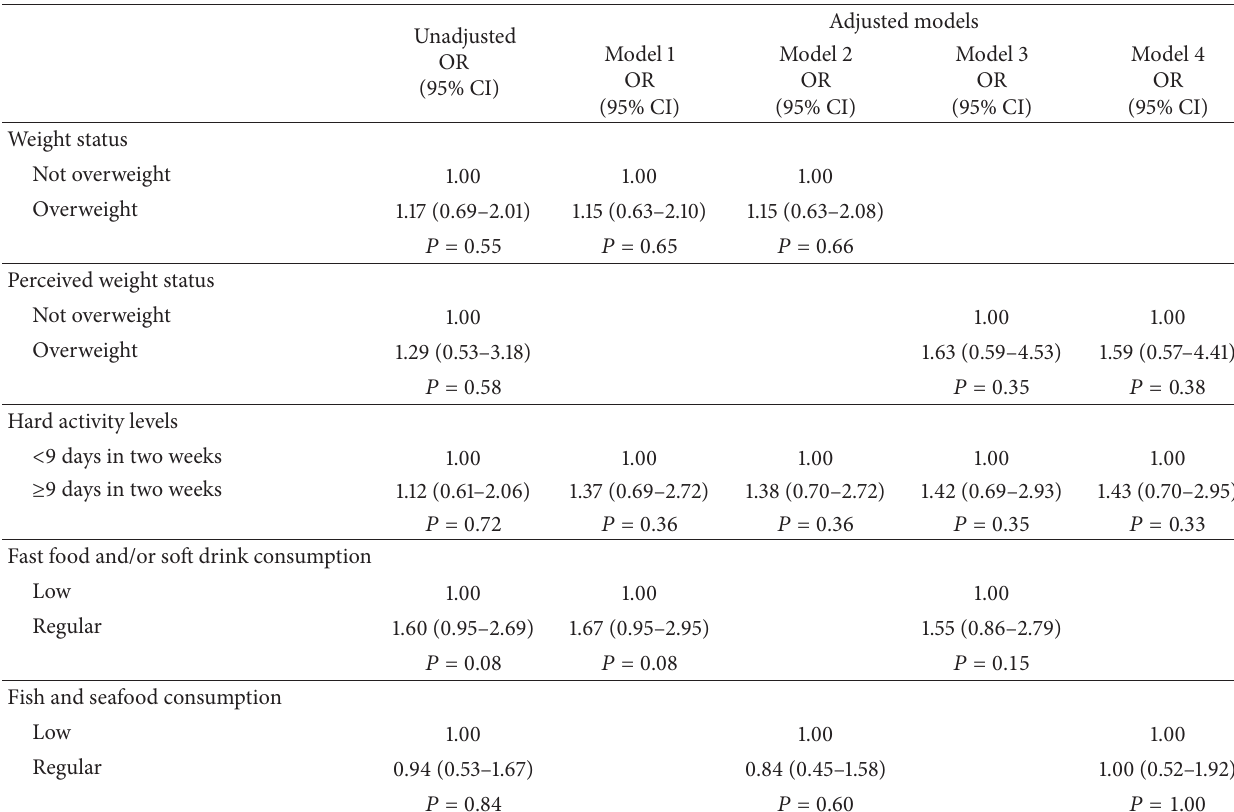
Table 2: Prevalence of lifestyle characteristics and unadjusted and multiple logistic regression ∗ results examining the associations between weight status and health behaviours with asthma or